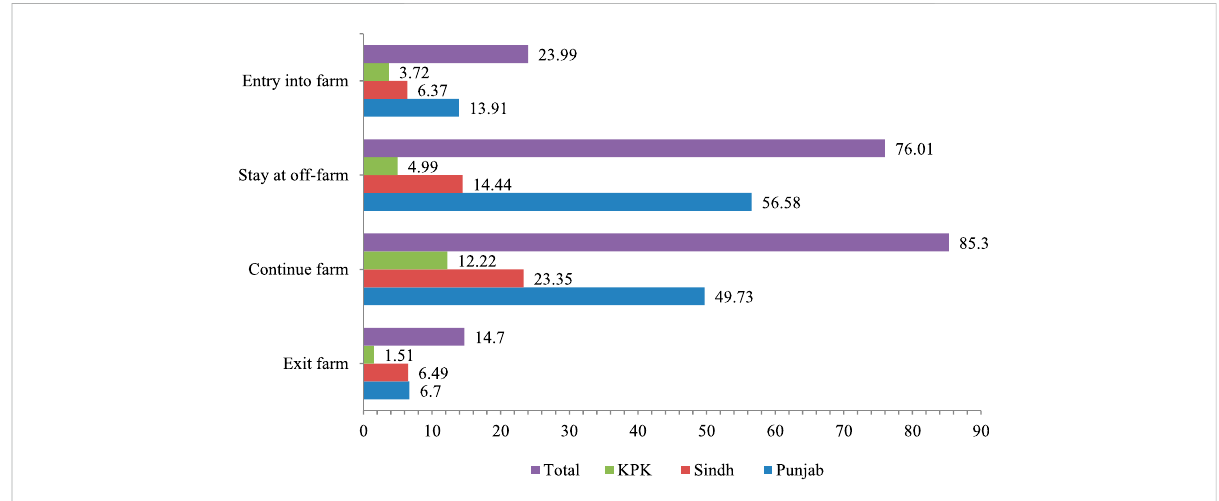
FIGURE 3 Household statuses based on entering and stay at off − farm and exiting and continuing farming.